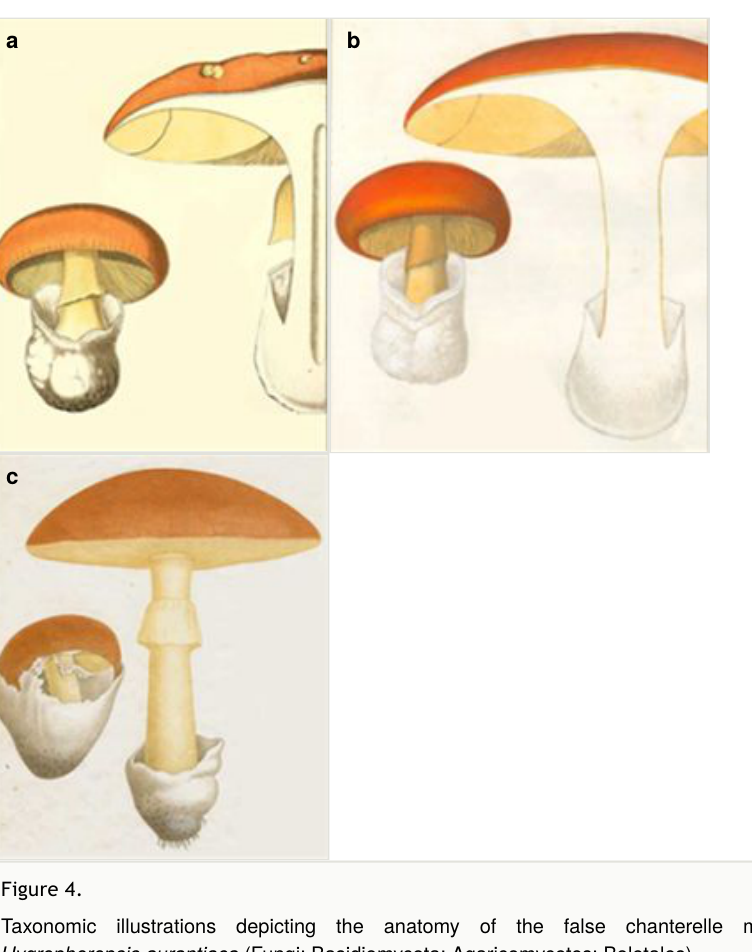
Taxonomic illustrations depicting the anatomy of the false chanterelle mushroom Hygrophoropsis aurantiaca (Fungi: Basidiomycota: Agaricomycetes: Boletales). a : From Bulliard (1776). b : From Bendiscioli (1827). c : From Roques Foraminifera are single-celled amoeboid protists, mostly less than 1 mm in length, that typically construct a test (or shell). Although Foraminifera are relatively simple organisms, the cardinal orientations of their anatomy have long been recognized by taxonomists. Fig. 5 includes excerpts from three taxonomic publications that deal with Sigmolina sigmoidea. It resembles a compressed sphere with a c-shaped pore at one end. A study from 1884 (Brady 1884) and another from 1917 (Cushman 1917) depict this species with the same three standard views: a lateral view, a straight on view centered on the aperture, and an axial cross section. Another work from 1974 (Ponder 1974) depicts several Sigmolina species, but employs the same three standard views to depict and compare them. Despite